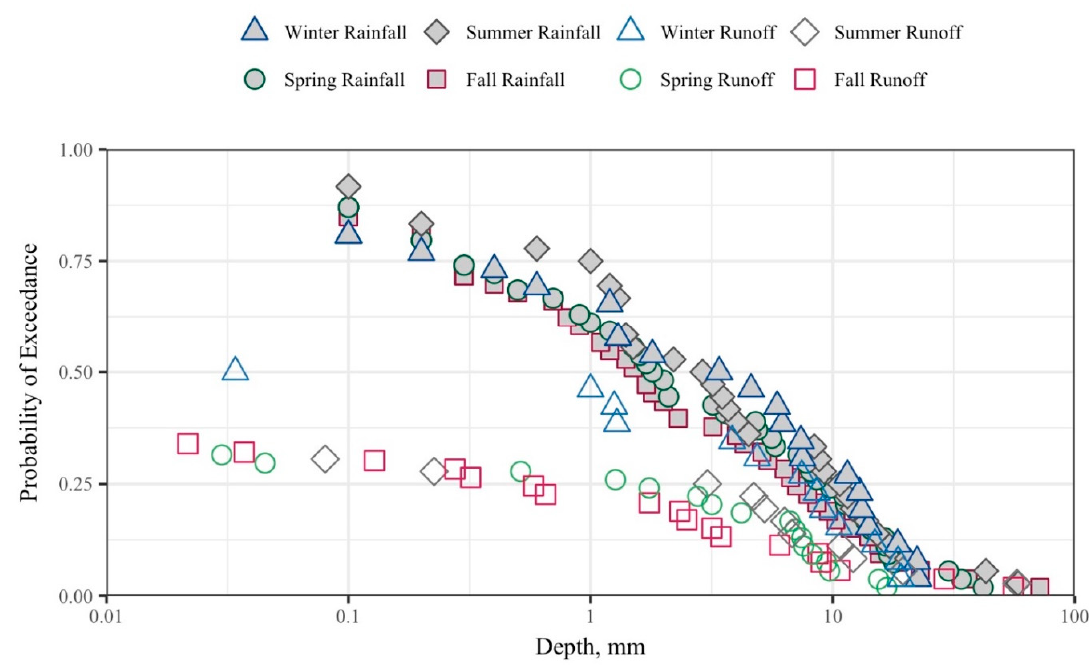
Figure 7. Event exceedance probability for runoff depth separated by season for the OnCenter green